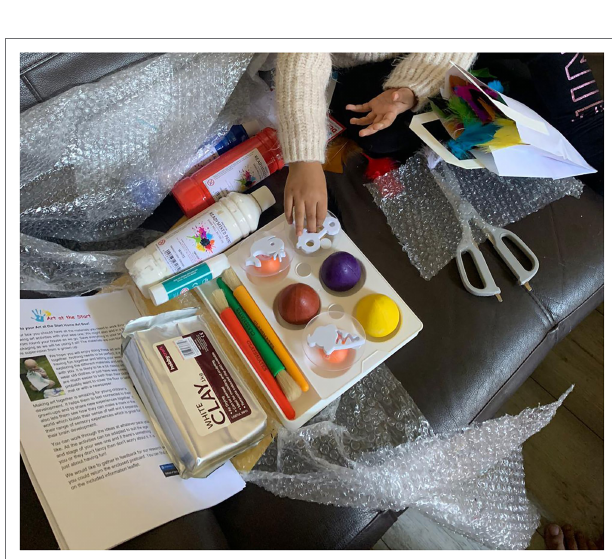
FIGURE 9 | The art materials laid out